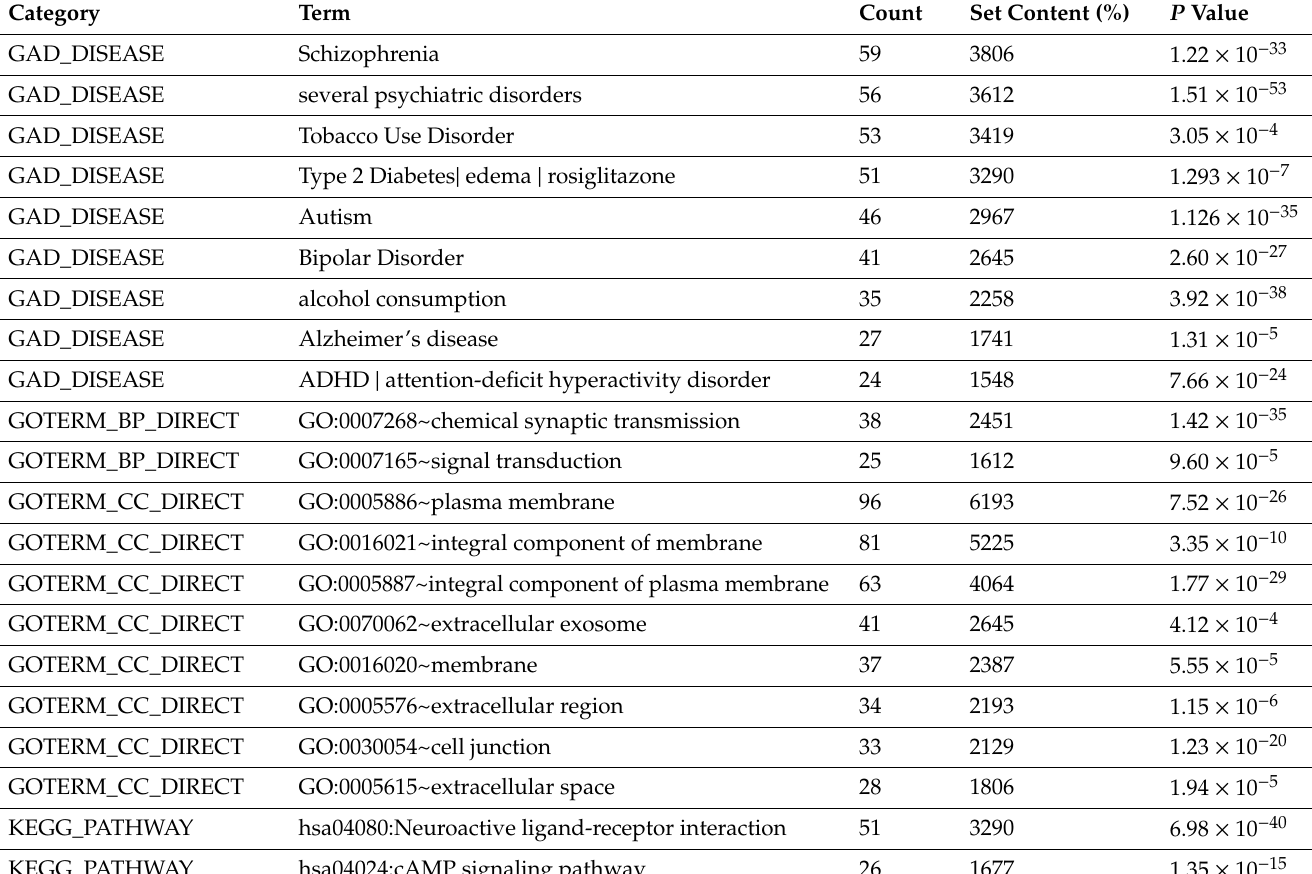
Table 1. GO enrichment analysis performed with DAVID GO for the formed gene